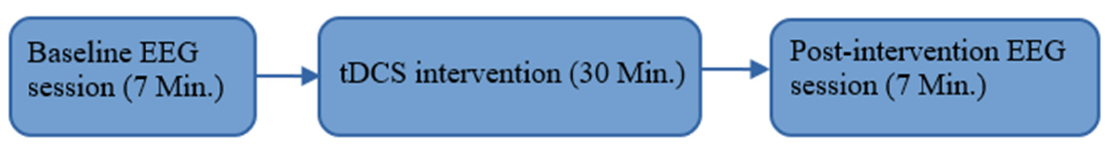
Figure 1. Flow diagram of study design and interventions.